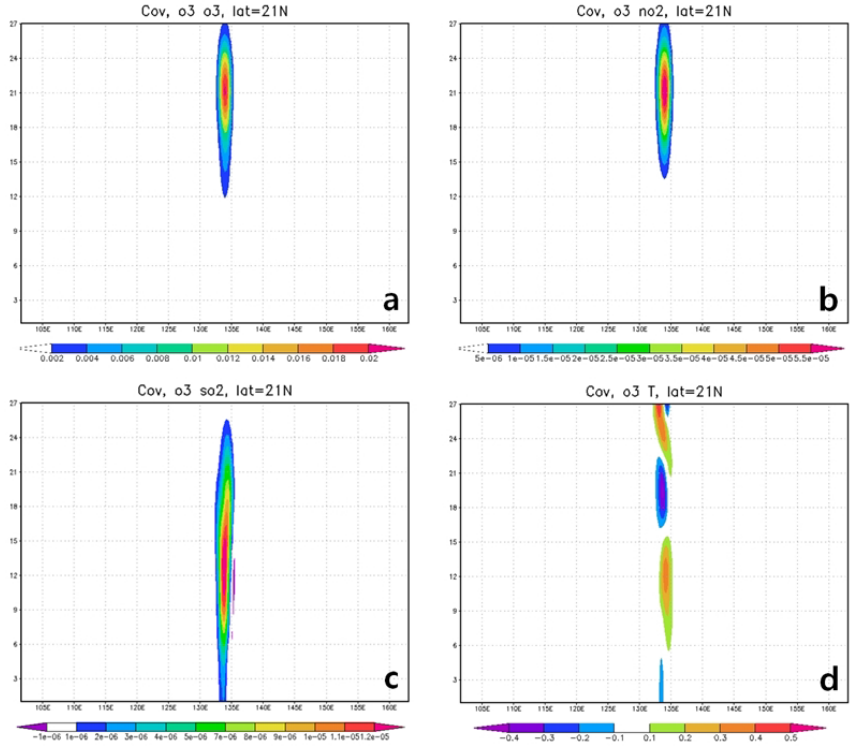
Figure 2. Same as in Fig. 1 but for the vertical cross section of the analysis increments (x a − x f ) in response to a single O 3 observation at 250hPa for (a) O 3 , (b) NO 2 , (c) SO 2 and (d) T